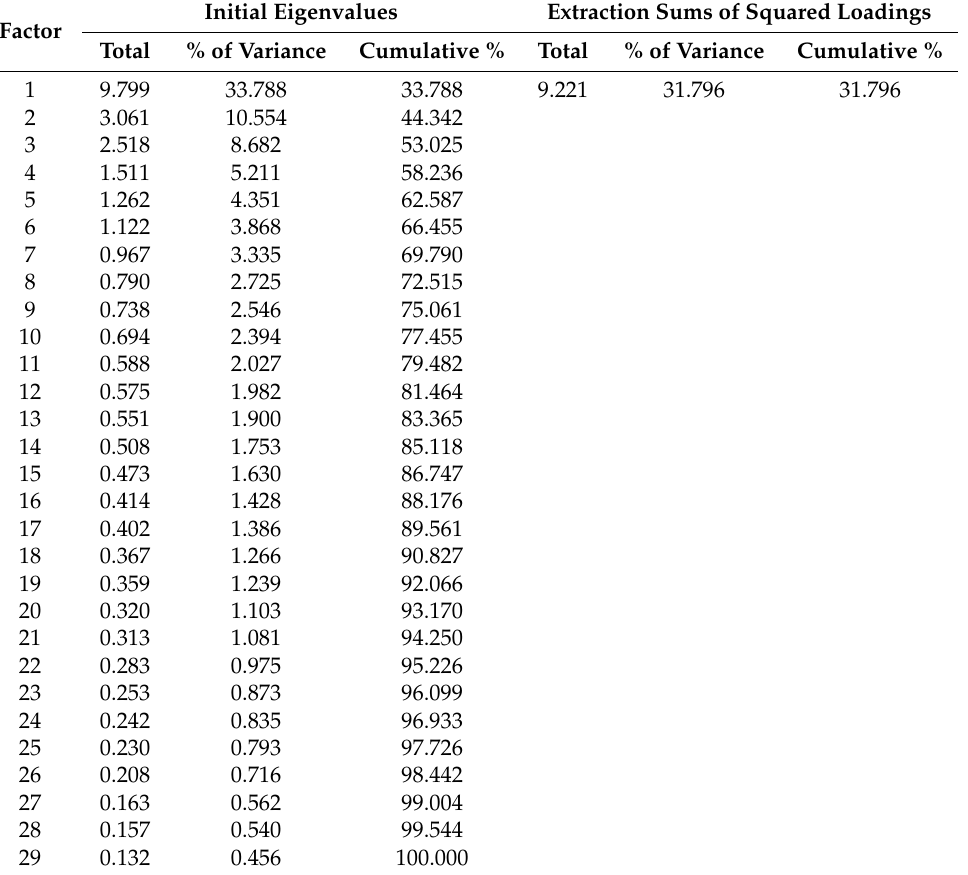
Table 2. Results of single-factor